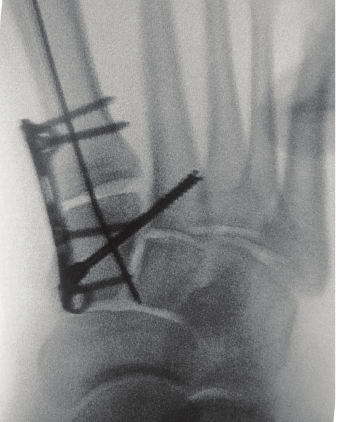
Figure 2: End fluoroscopic control prior to removal of the K wire.